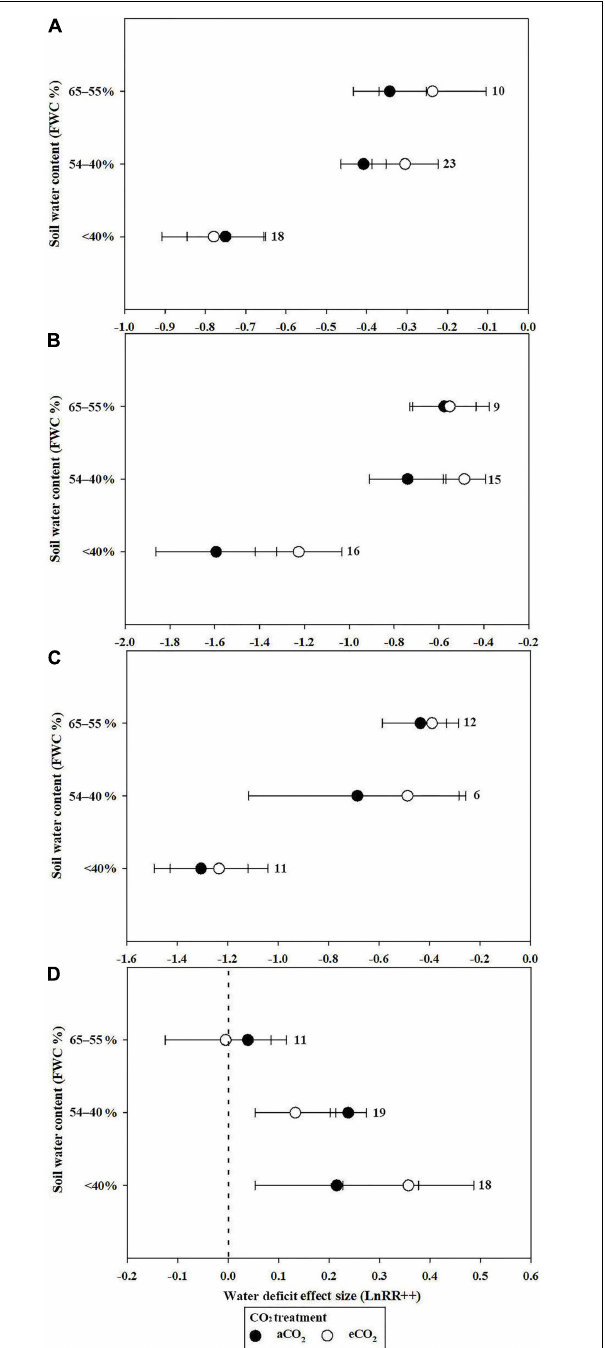
FIGURE 2 | Mean effect sizes of e[CO 2 ] on P n (A) , G s (B) , T r (C) , and WUE (D) under well-watered (black diamond) and water deficit (white diamond) conditions. e[CO 2 ] treatments were divided into seven categories as stated on the y -axis.